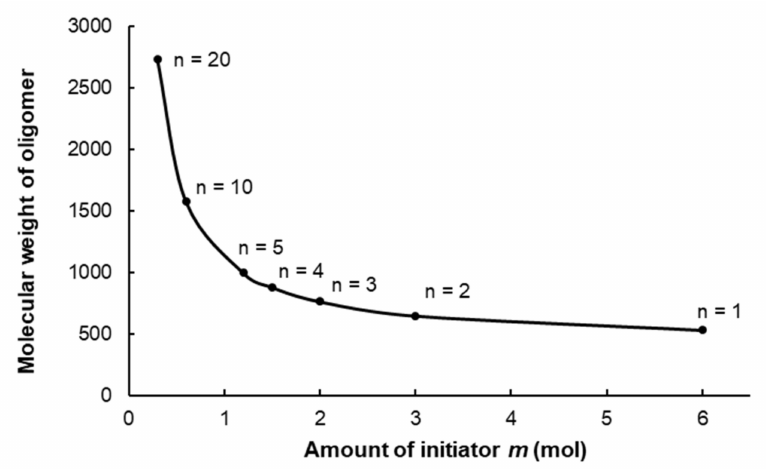
Figure 5. Dependence of molecular weight of linear oligodichlorophosphazene [Cl(PCl 2 =N) n PCl 3 ] + [PCl 6 ] − from amount of initiator PCl 5